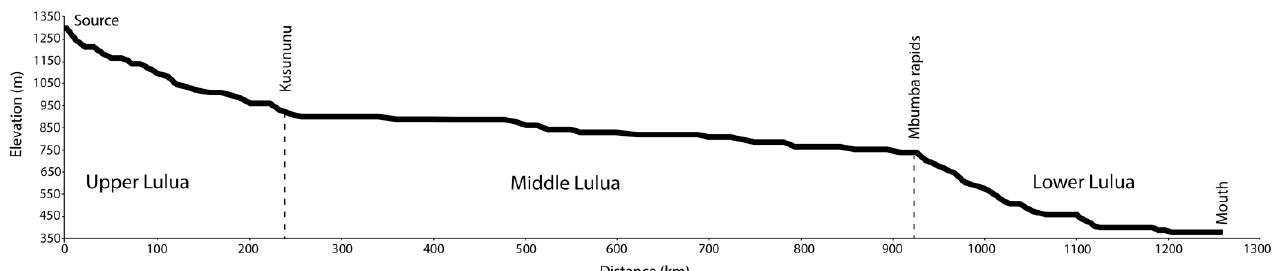
Figure 2. Longitudinal profile of the Lulua River and its subdivision into three sections based on the channel slope gradi- ent.